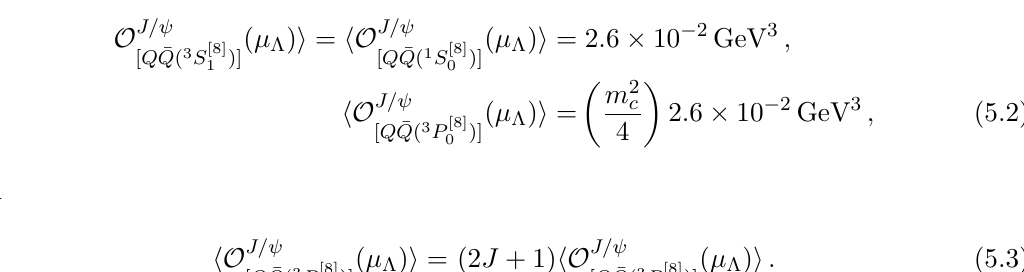
Figure 8 . Numerical results for various NRQCD channels at various CM energies 10 : 6, 30, and 100 GeV with LDME choices described in the text. For Q = 10 : 6 GeV, Belle data is shown. of